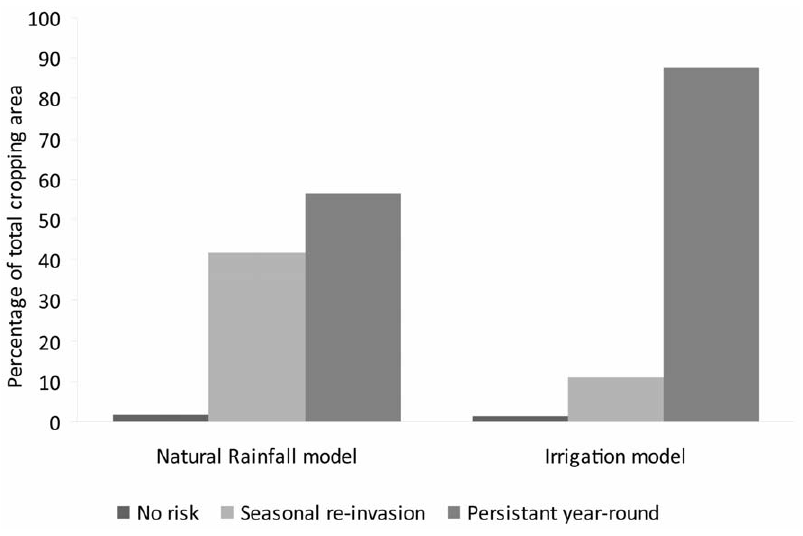
Figure 6. Proportion of total cropping area in Australia that is at risk of persistent year round populations of Rhopalosiphumpadi or seasonally transient populations. Data generated by a CLIMEX model illustrating the asexual mode of reproduction in this species under natural rainfall conditions and incorporating an irrigation scenario.